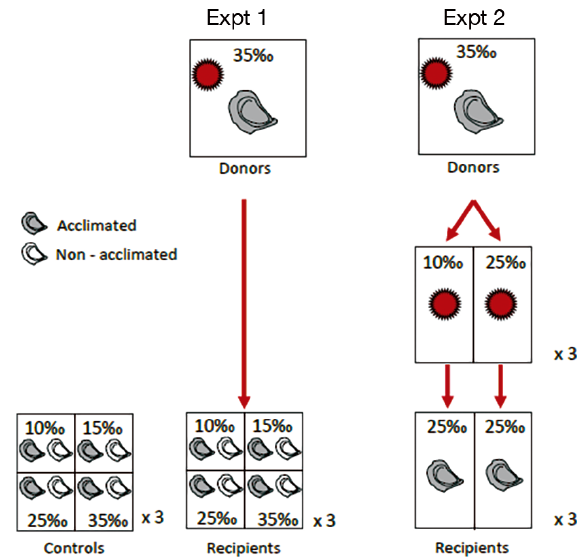
Fig. 2. Schematic of experimental designs. Expt 1: Study of the effect of salinity on disease transmission and related mortality of Pacific oysters Crassostrea gigas , in particular in the presence of ostreid herpesvirus OsHV-1 μ Var. We used 2 infection levels × 4 salinity treatments × 3 replicate tanks × 2 acclimation levels (within tank). Expt 2: Study of the effect of salinity on pathogens, in particular on OsHV-1 μ Var. We used 2 salinity treatments × 3 replicate